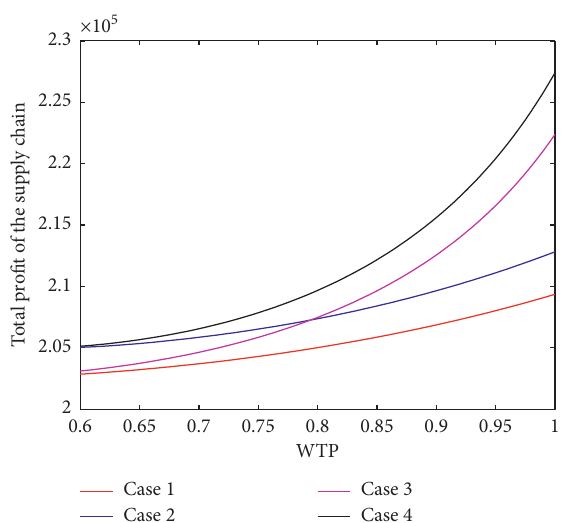
Figure 12: Total profit of the entire supply chain vs.